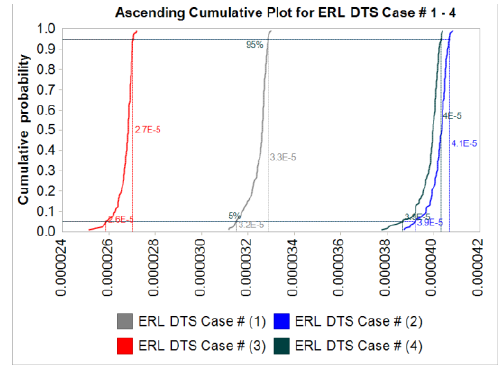
Figure 12. Cumulative Probability Distribution for Case #1 to #4—DTS, Performance & Performance with HOE.